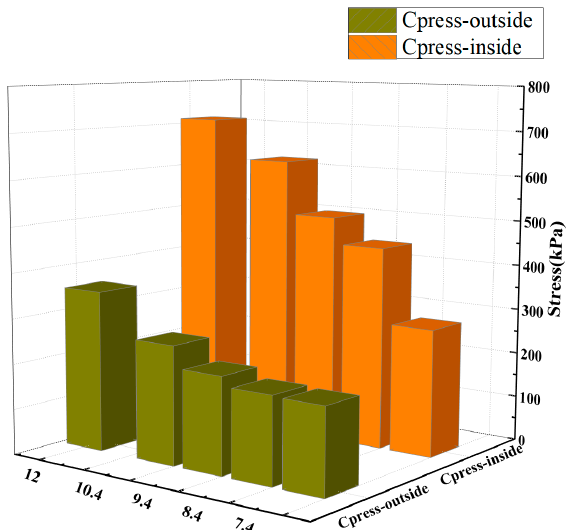
Figure 8. Contact stress of skirt under different bucket skirt heights.